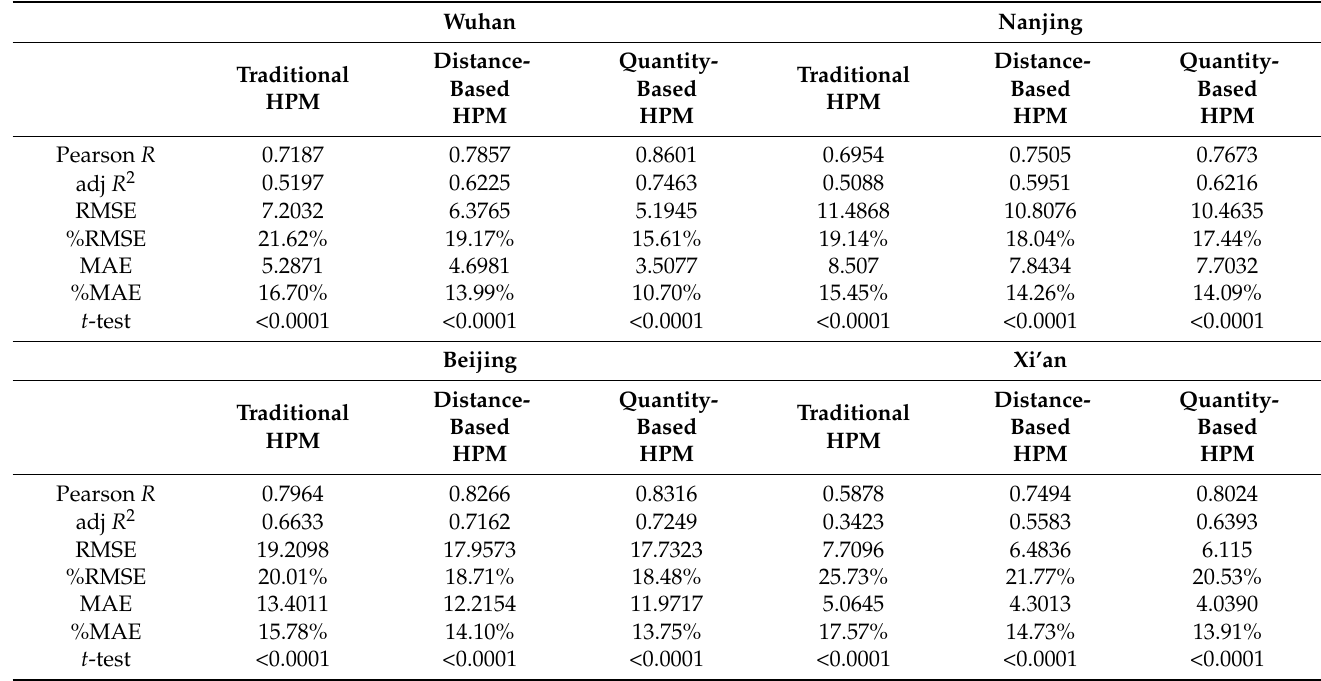
Table 3. Accuracy assessment results of HPM with different locational and neighborhood variables— the traditional, distance-based, and